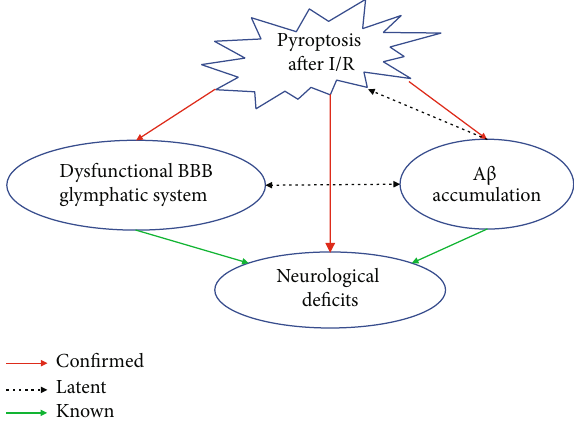
Figure 7: Schematic diagram about internal relationships among pathological changes in this study. Red arrows present relationships con fi rmed by this study among pathological changes including pyroptosis, A β accumulation, dysfunctional BBB- glymphatic system, and neurological de fi cits after I/R, and dotted arrows and green arrows, respectively, present latent and known relationships obtained on the basis of previous